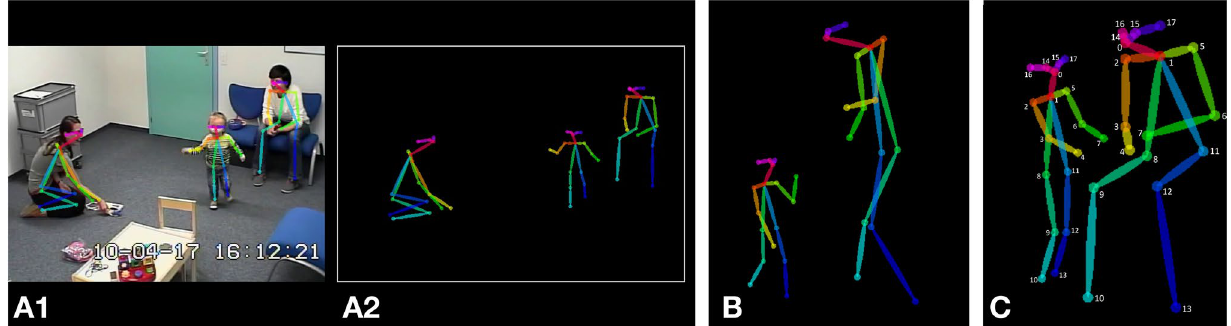
Figure 1. Example of 2D pose estimation using OpenPose on ADOS video frames: ( A1 ) OpenPose keypoints overlaid a video recording from the ADOS assessment, ( A2 ). OpenPose skeletal keypoints plotted over a null background, ( B ). Example of requesting behavior with skeletal points, ( C ). Example of showing behavior with numerated keypoints. Keypoint list: 0 = nose, 1 = heart, 2 = right shoulder, 3 = right elbow, 4 = right wrist, 5 = left shoulder, 6 = left elbow, 7 = left wrist, 8 = right hip, 9 = right knee, 10 = right ankle, 11 = left hip, 12 = left knee, 13 = left ankle, 14 = right eye, 15 = left eye, 16 = right ear, and 17 = left